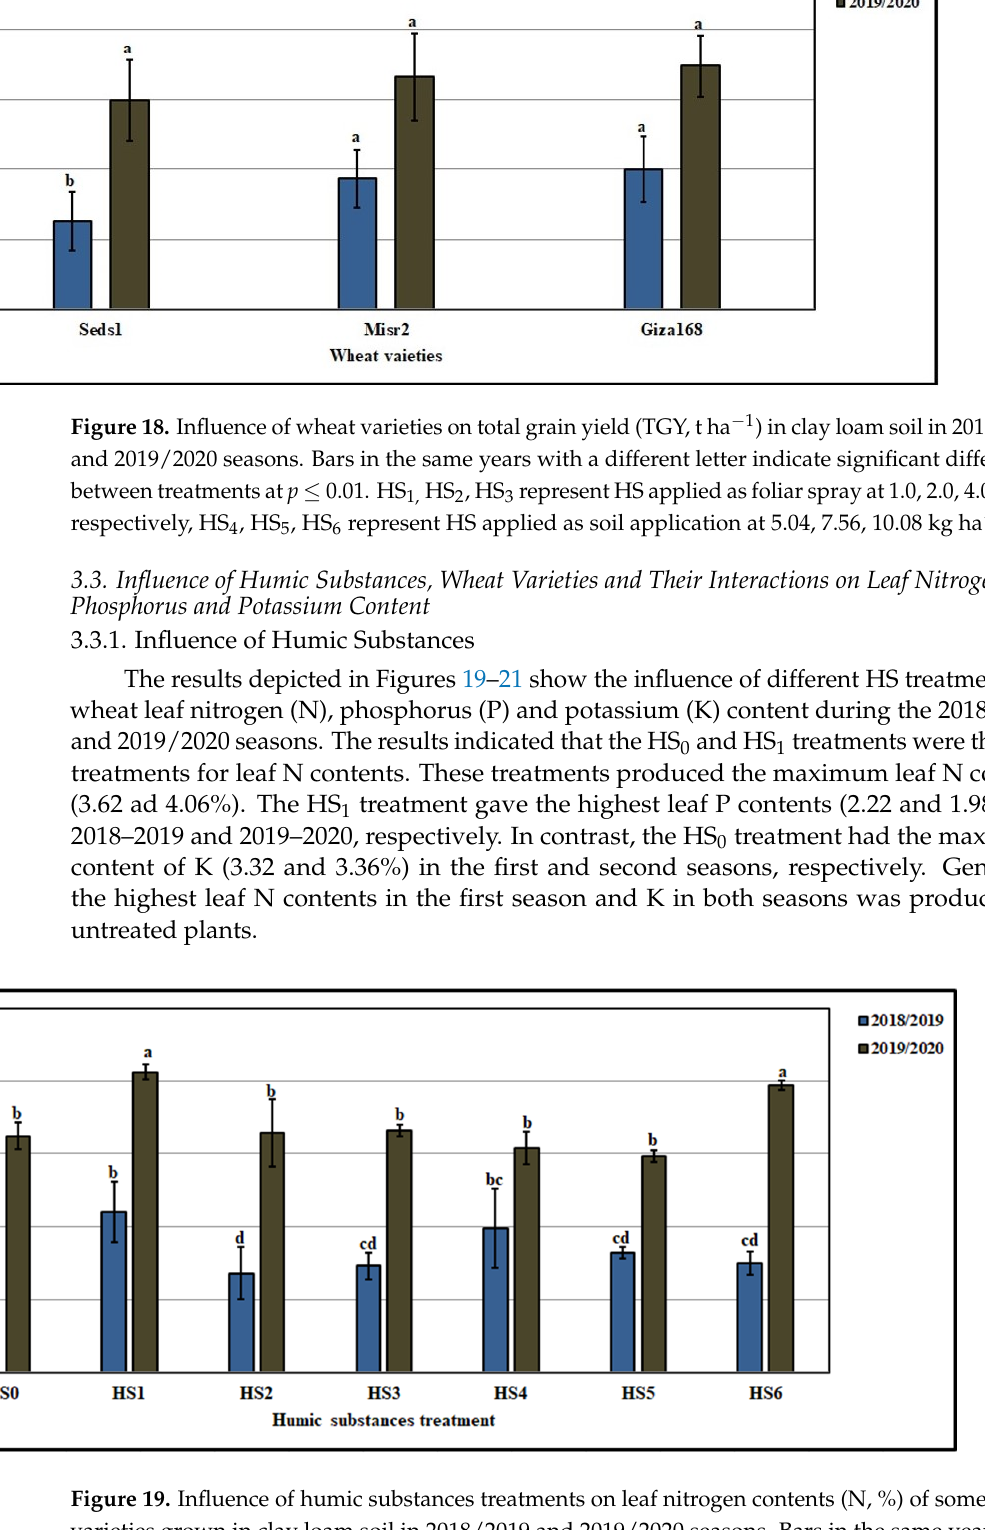
Table 7. Influence of humic substances doses on 1000-grain weight, biological yield and total grain yield of some wheat varieties grown in clay soil in 2018/2019 and 2019/2020 seasons.